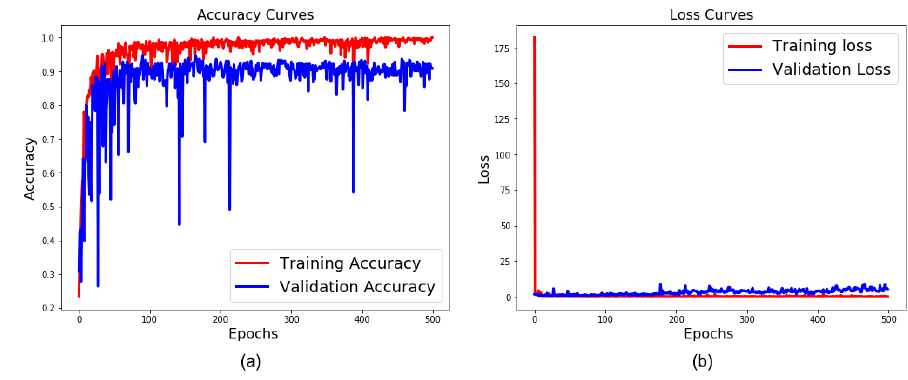
Figure 9. ( a , b ) Accuracy curve and loss curve with DCNN facial expression recognition.